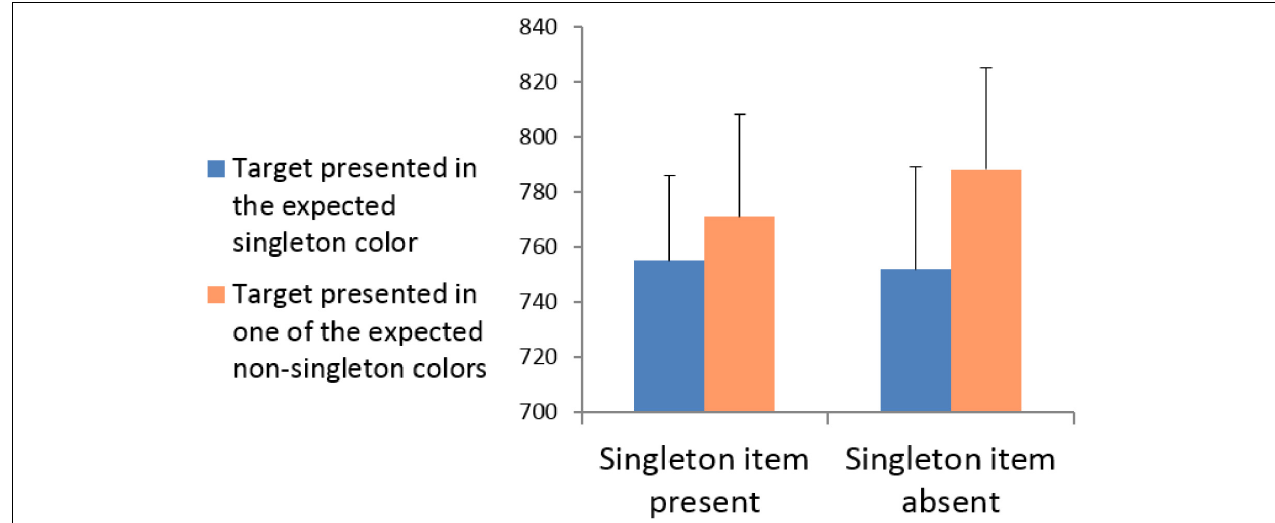
FIGURE 4 | Experiment 2: Mean RTs for targets presented in the singleton color vs. targets presented in non-singleton colors for singleton-present and singleton-absent displays.